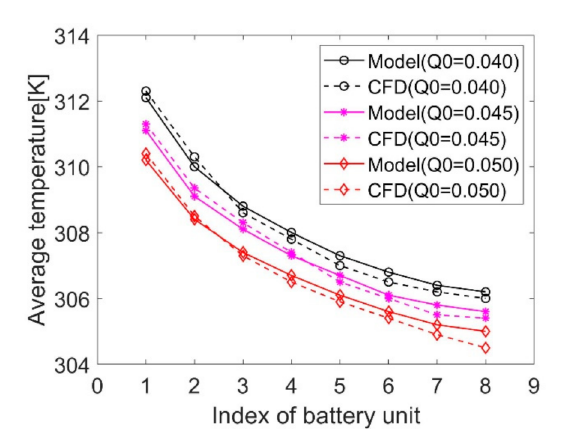
Figure 7. Battery unit temperatures comparison obtained by mathematical model and CFD